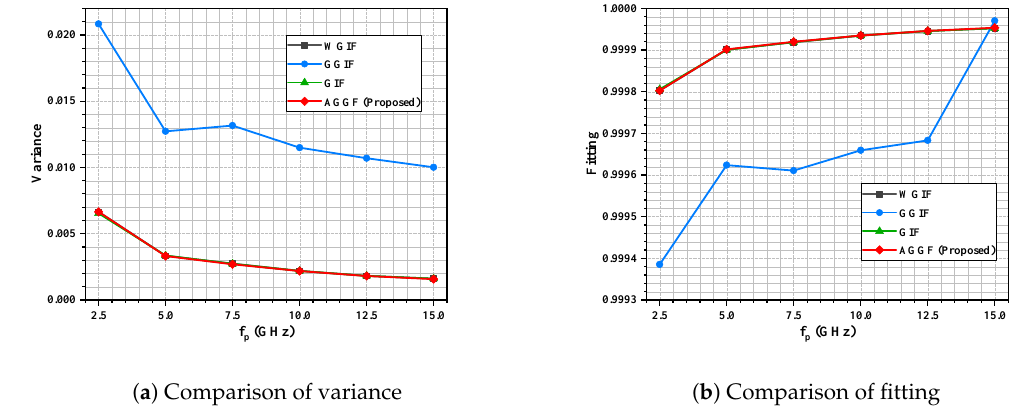
Figure 10. Indoor experiment, SNR = 30; influence of f p on filtering effect.